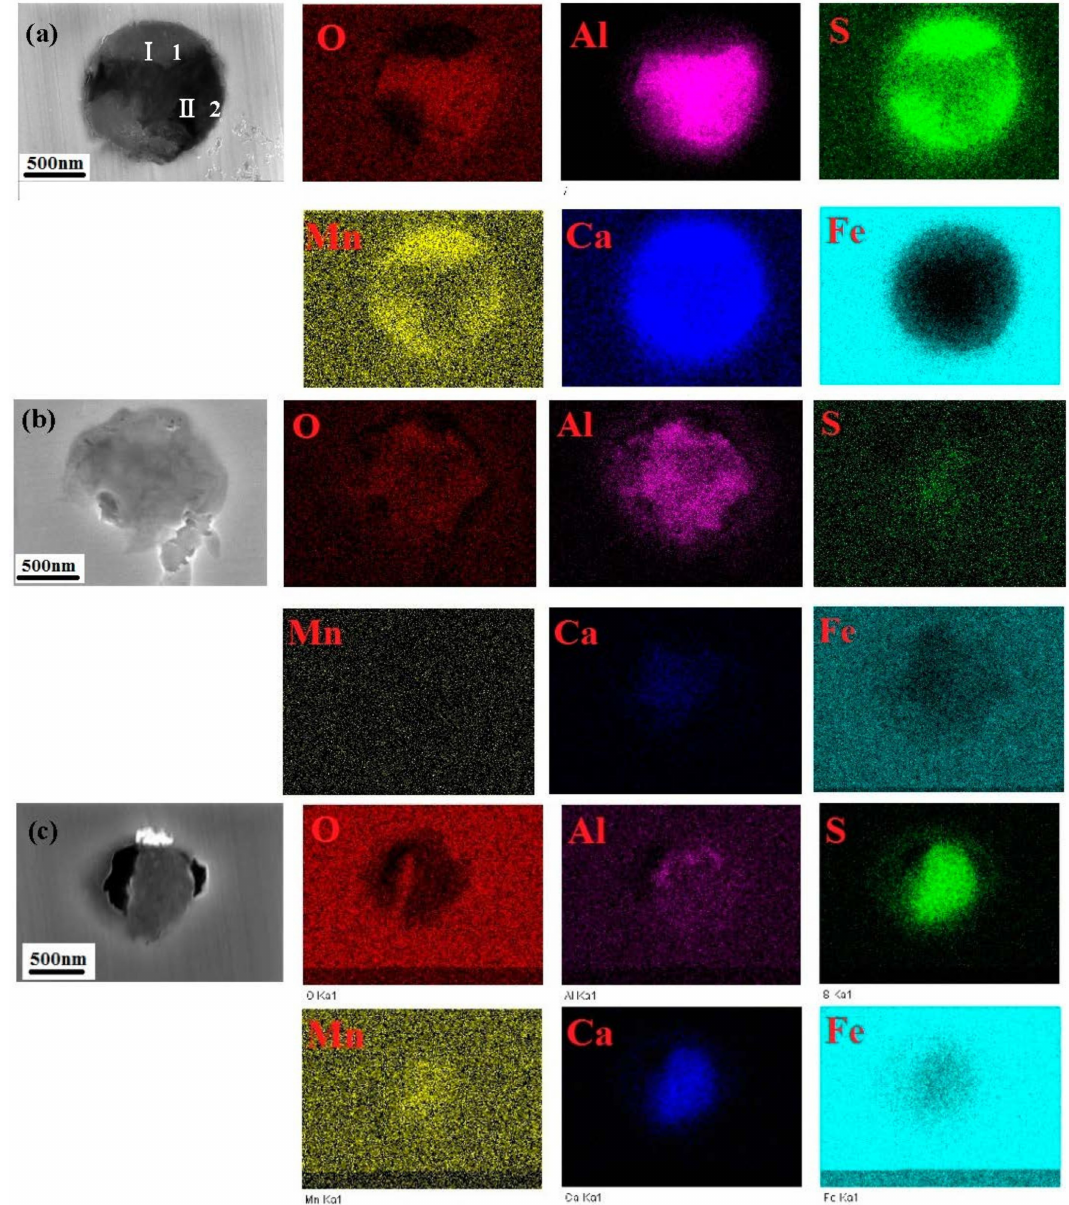
Figure 2. EDS composition maps of the inclusions in X70 steel: ( a ) Type A; ( b ) Type B and ( c ) Type